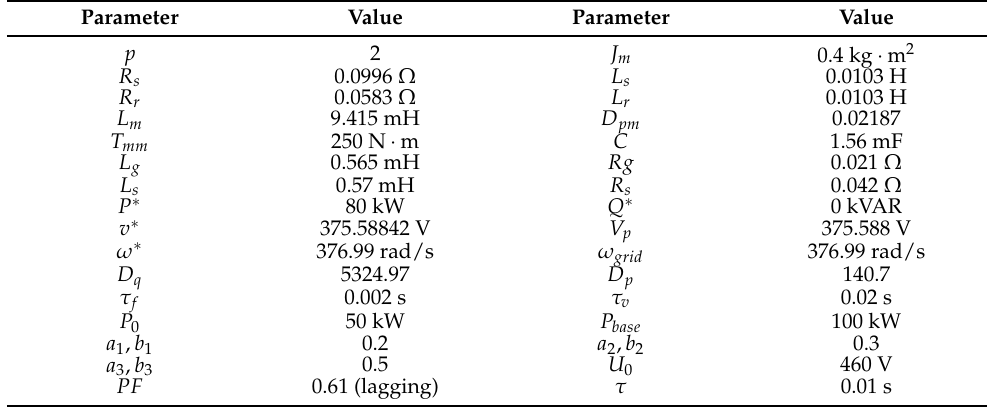
Table 2. Synchronverter-based system parameters.